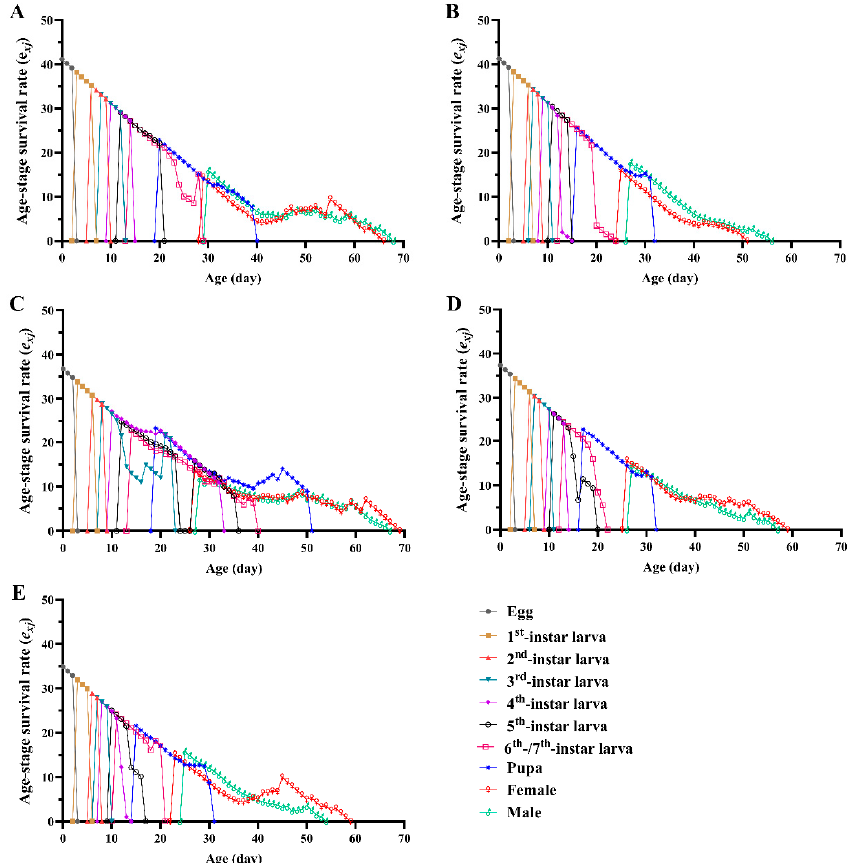
Figure 4. Age-stage specific life expectancy ( e xj ) of Spodoptera frugiperda individuals fed different diets. ( A ): D 1 ; ( B ): D 2 ; ( C ): D 3 ; ( D ): D 4 ; ( E ): maize leaves.